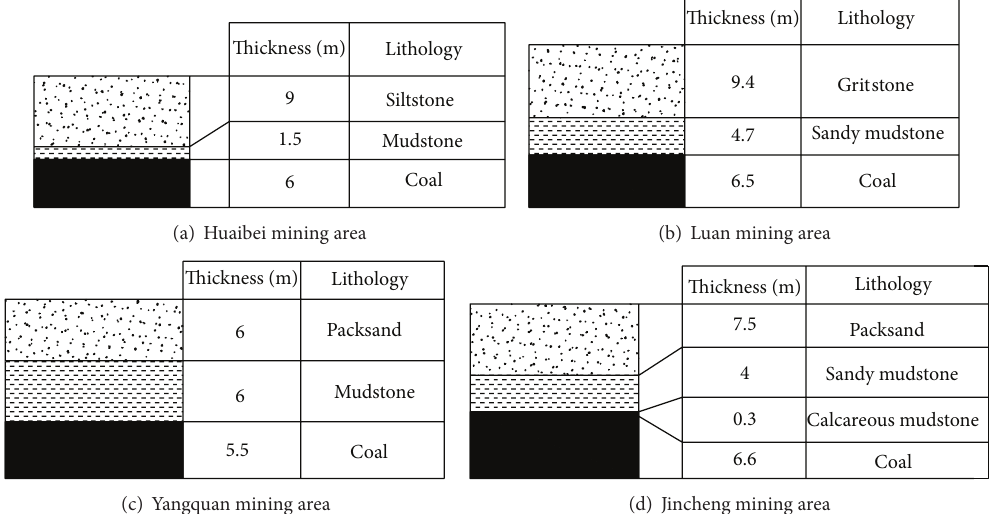
Figure 1: Typical thick coal seam occurrence characteristics in four mining areas.